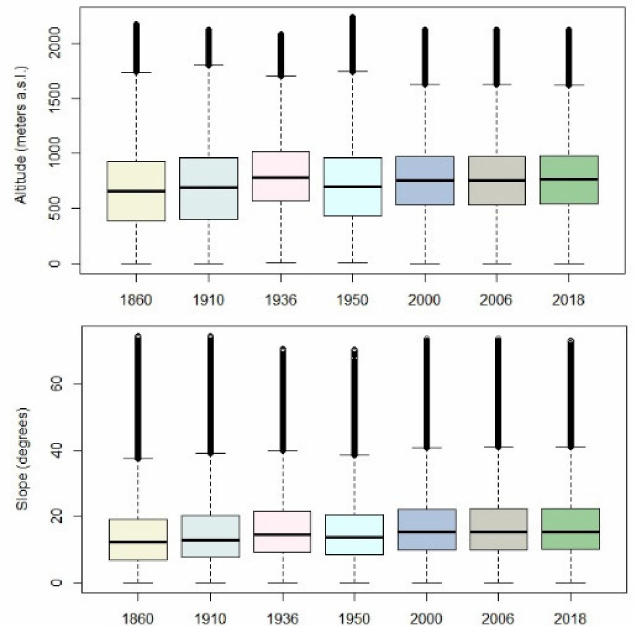
Figure 6. Box plots of topographical parameters (altitude and slope) for each year of analysis. Circles specify outliers; the horizontal lines within the box specify the median value of each parameter. The bottom of box is at the first quartile (25% of the distribution), and the top is at the value of the third quartile (75% of the distribution), while the whiskers indicate variability outside the upper and lower quartiles.